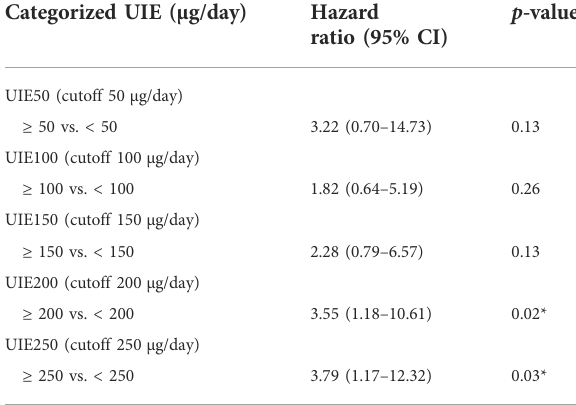
TABLE 2 Relative hazard ratios (HRs) and 95% con fi dence interval (CI) of progression for urinary iodine excretion (UIE) using the univariate Cox proportional regression analysis.